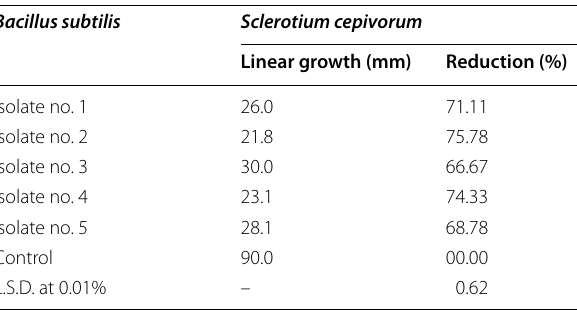
Table 1 Effect of Bacillus subtilis isolates on linear growth of Sclerotium cepivorum grown on nutrient glucose agar medium at 25 2 °C ± Bacillus subtilis Sclerotium cepivorum